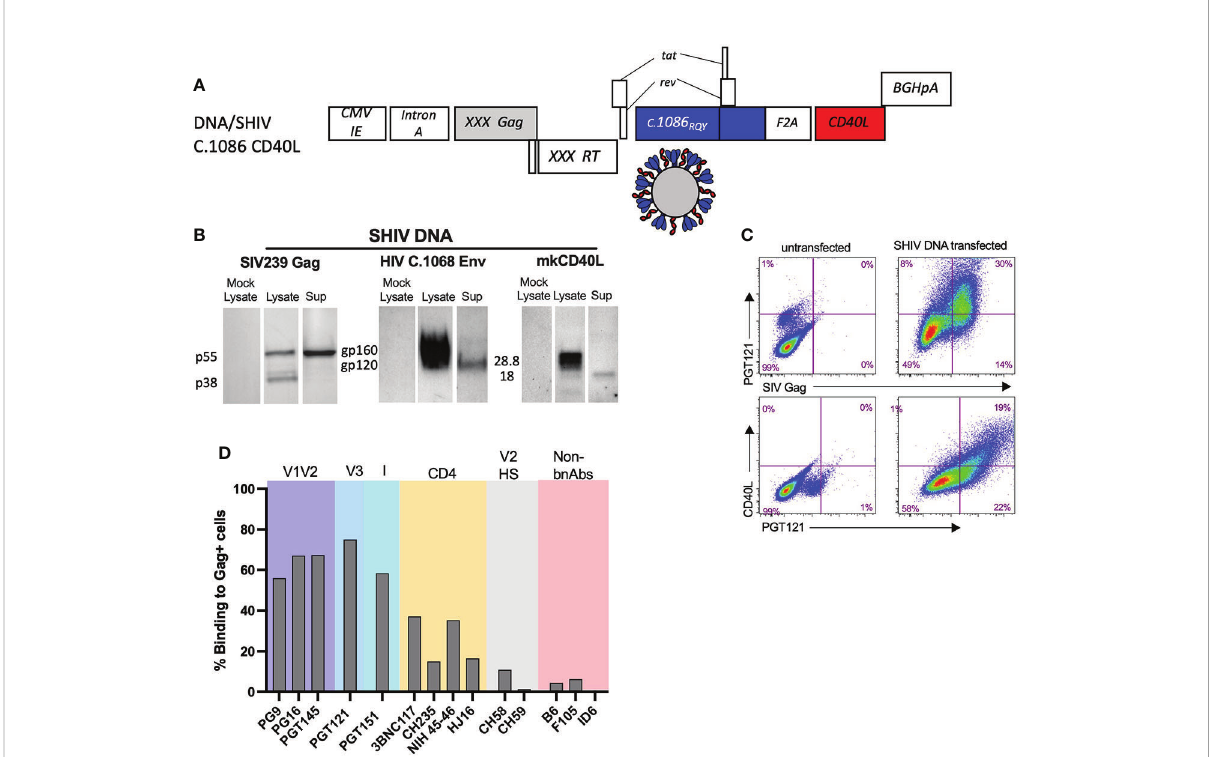
FIGURE 1 Characterization of SHIV DNA. (A) Schematic of SHIV DNA construct. (B) Western blot analysis of SIV Gag, HIV C.1086 Env, and Rhesus CD40L in the lysate and supernatant of transfected 293 T cells. (C) Flow cytometry of 293 transfected cells depicting the surface co-expression of HIV Env and rhesus CD40L on SIV Gag positive cells (D) Surface binding of bNAbs and non-bNAbs to SIV Gag positive DNA transfected